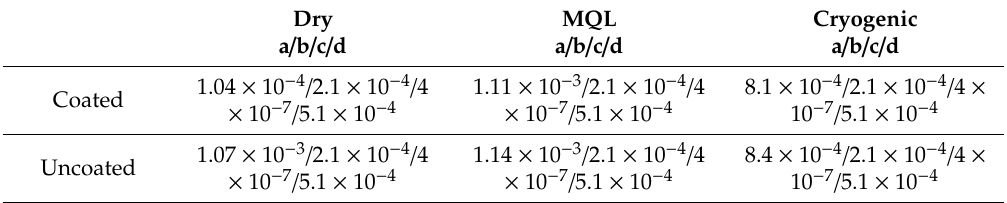
Figure 11 highlights a normal distribution of the data. The distribution is close to a straight line and there are some outliers, which were not included in the calculation of the model.